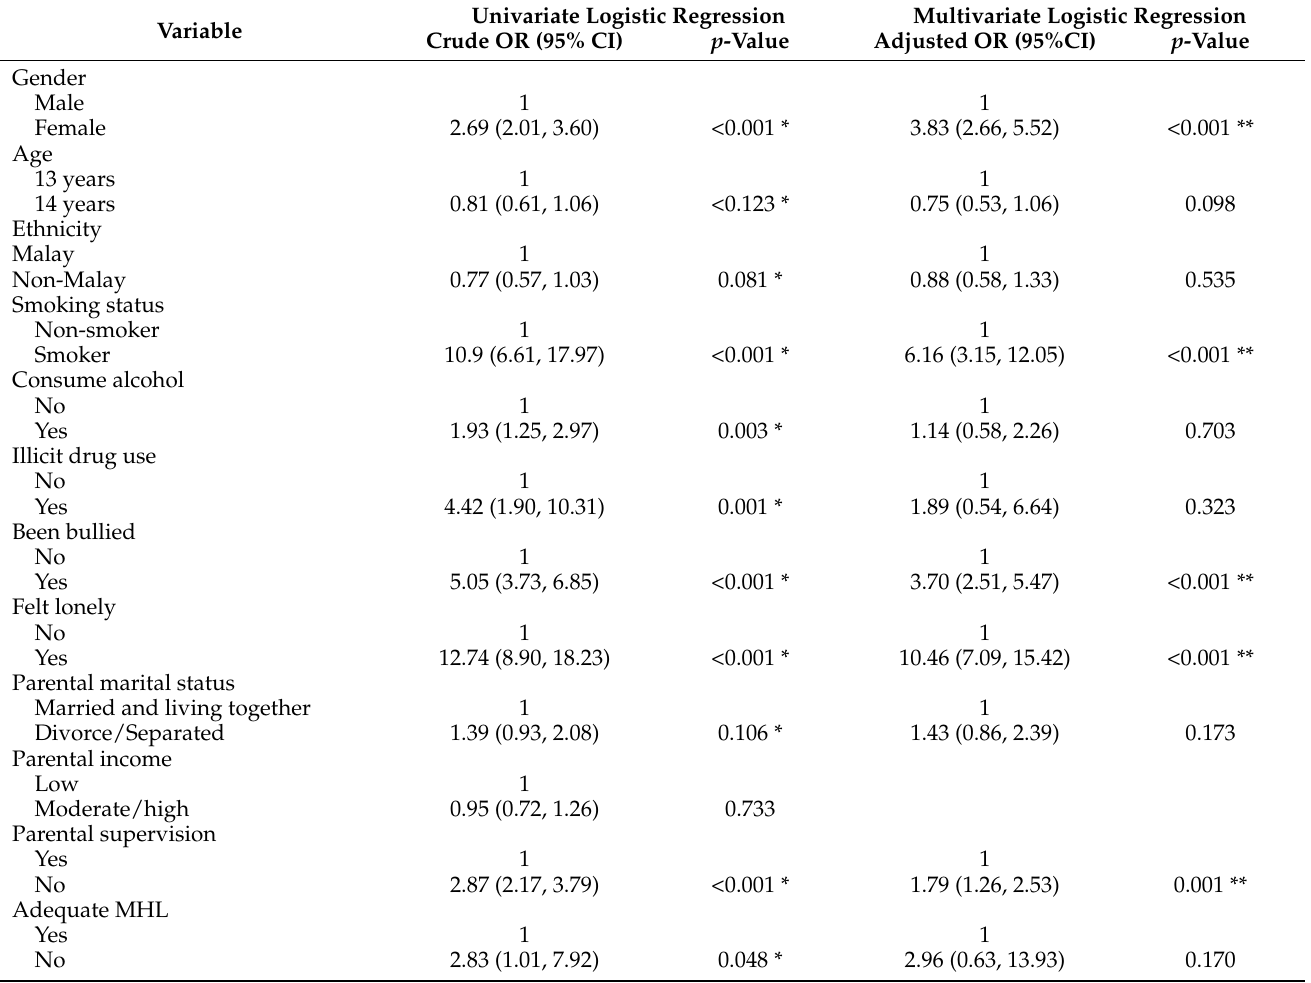
Table 2. Factors associated with depressive symptoms among adolescents (N =